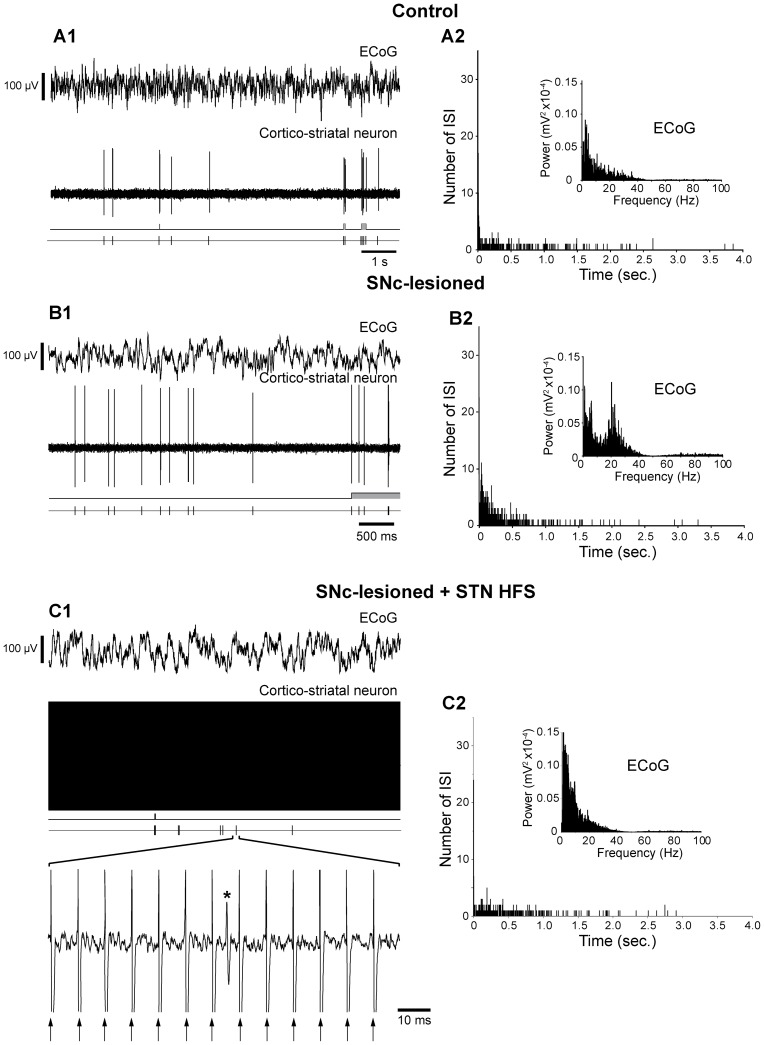
Effect of SNc lesion and impact of STN HFS on the spontaneous activity of cortico-striatal cells and the electrocorticogram (ECoG) of the orofacial motor cortex.The spontaneous activity of a cortico-striatal neuron was extracellularly recorded simultaneously with the ECoG signal of the orofacial cortex in control rats (A), and in SNc-lesioned animals, before (B) and during STN HFS (C). Note that the SNc lesion induced an increased firing rate of the cortico-striatal neuron (B1) that was accompanied by an increased number of bursts and by the appearance of an excessive hypersynchronisation in the beta frequency band in the ECoG (B2, inset) compared to control situation (A1, A2, inset). These SNc lesions-induced changes were abolished during STN HFS (C). In panels A1
,
B1, and C1, the different traces correspond, from the top to the bottom, to the ECoG signal, the simultaneous extracellular recording of the cortico-striatal cell, the bursting discharge detected by Poisson Surprise analysis (S≤2) and the discharge of the cell represented as a sequence of spikes. In panels A2
,
B2, and C2, histograms display the corresponding interspike intervals and insets show the power spectrum (FFT) of the corresponding ECoGs. In C1, arrows indicate the stimulation artifacts and the asterisk an action potential. Abbreviation: ECoG: electrocorticogram; FFT: Fast Fourier Transform; HFS: high-frequency stimulation; ISI: interspike interval; SNc: substantia nigra pars compacta; STN: subthalamic nucleus.